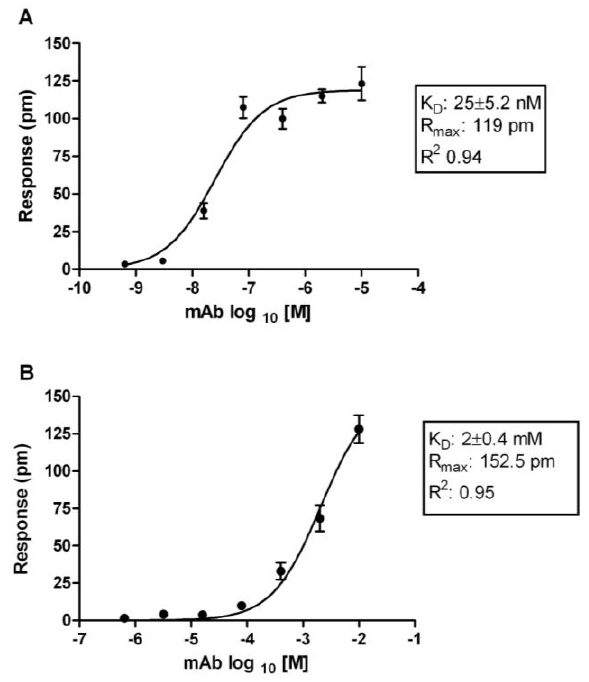
Figure 1. Representative binding isotherms for mAbs binding to non-structural 1 (NS1) measured by Resonance Waveguide Grating (RWG). ( A ) shows the saturated binding model of NS1 mAb (Dv1 M1) to immobilized DENV NS1 protein, which generally produced middle to high affinity in RWG; ( B ) demonstrates the non-saturable binding model (Dv1 M4), which generally corresponded with low affinity. Values were given as mean ± standard error of the mean for n =